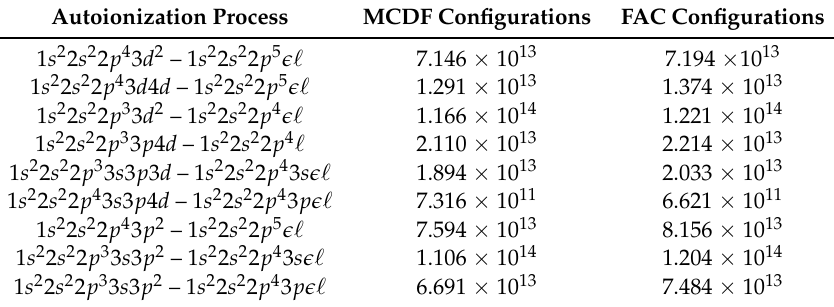
Figure 21. Values of the autoionization rates between relativistic subconfigurations of 2 p 3 3 s 3 p 2 − 2 p 4 3 s (cid:101) (cid:96) . The dashed line represents the value between non-relativistic configurations 2 p 3 3 s 3 p 2 and 2 p 4 3 s (cid:101) (cid:96) . Orbital n (cid:96) j is noted n (cid:96) − if j = (cid:96) − 1/2 and n (cid:96) + if j = (cid:96) + 1/2. Table 5. Values of the configuration-averaged autoionization rate (s − 1 ) computed with FAC [92] and MCDF [90,91] codes for different